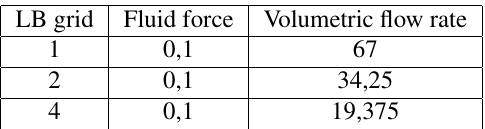
Table 1. Testing di ff ernet LBgrid values with the same fluid